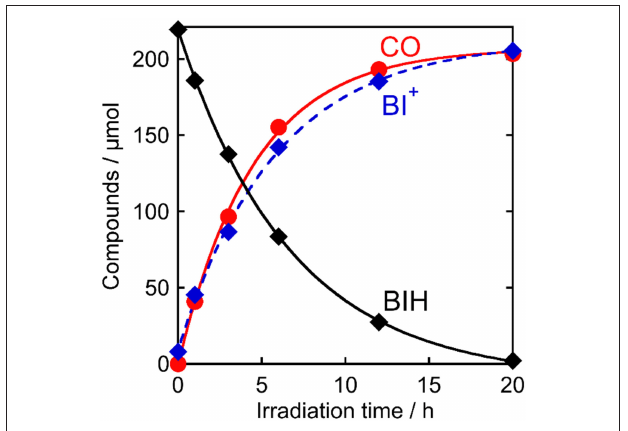
FIGURE 7 | Photocatalytic production of CO ( ) and BI + ( ) and consumption of BIH ( (cid:7) ): CO 2 -saturated DMA-TEOA (5:1 v/v) solutions containing Ru(pic) (50 µ M), Re (50 µ M), and BIH (0.1M) were irradiated at λ ex >